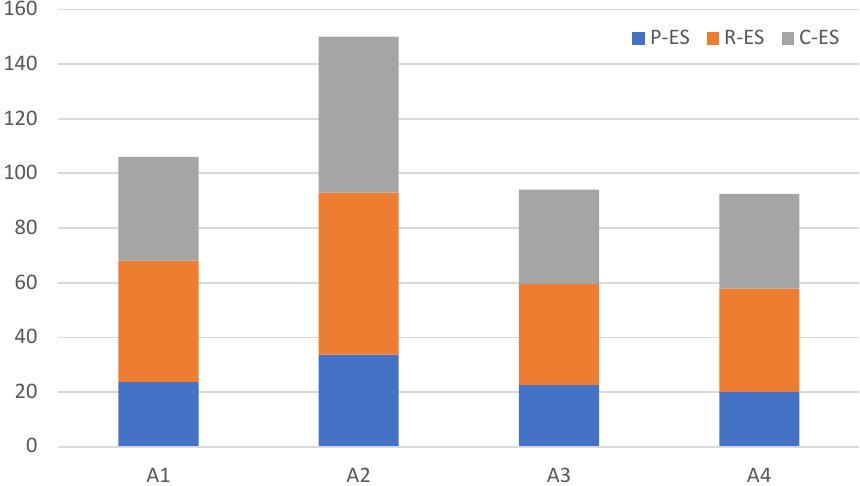
Figure 5. Impact of access roads in terms of ES. The impacts in terms of R-ES and C-ES for A4 are slightly higher than those for A3. Values for the P-ES, R-ES and C-ES were calculated using Equation (1) ( E k ).